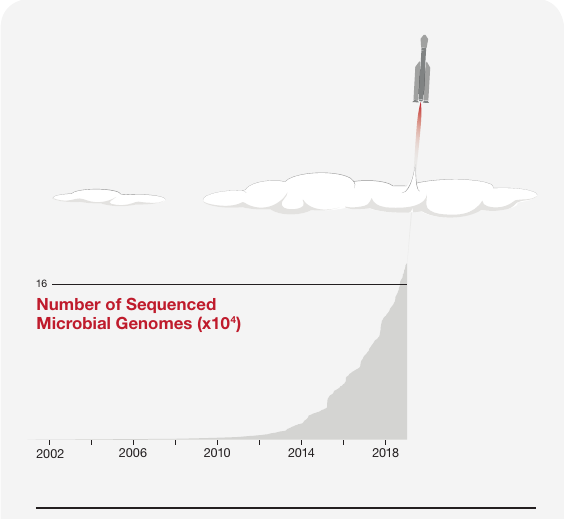
Figure 3. The exponential increase in microbial genomic sequences is fueling a new era of molecular